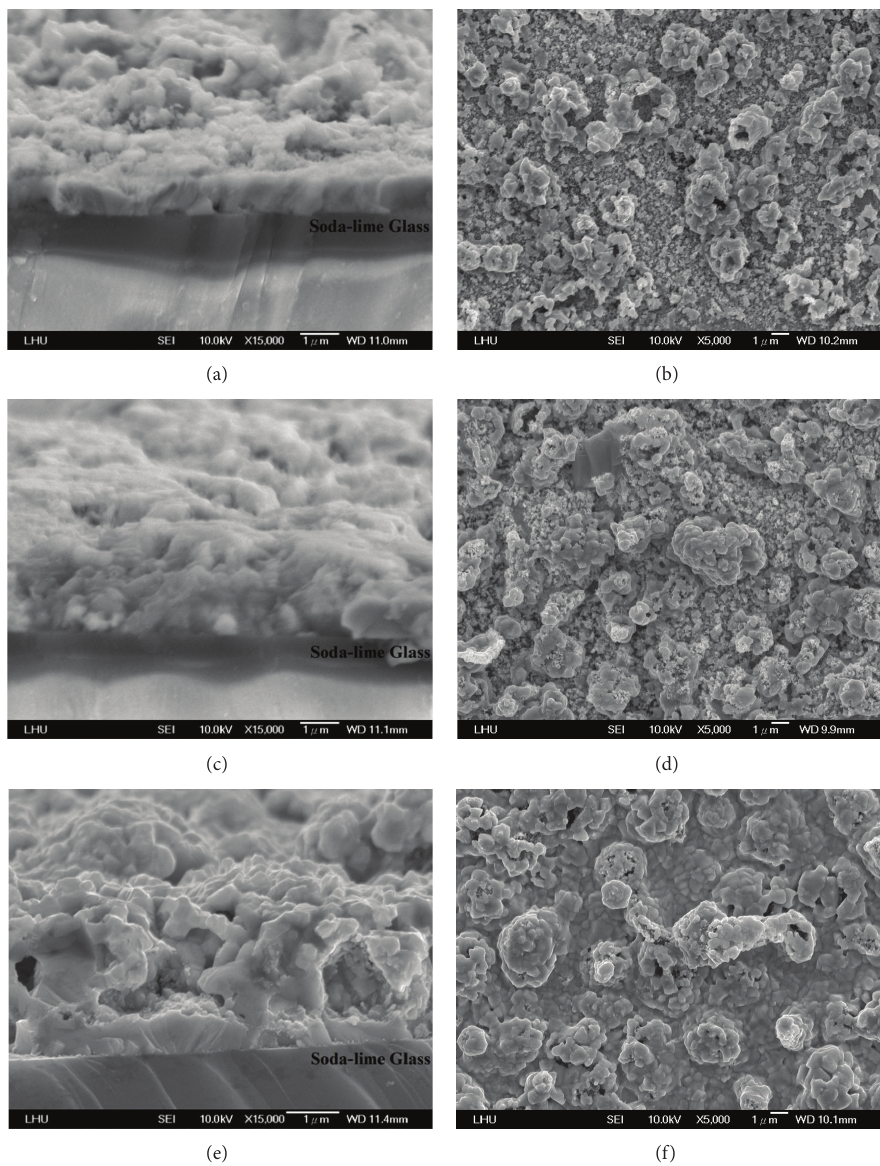
Figure 6: Cross-sectional and top-view SEM images of the CIGS films selenized at (a), (b) the lowest (1Torr), (c) and (d) 100Torr, and (e) and (f) the highest Ar pressure (300